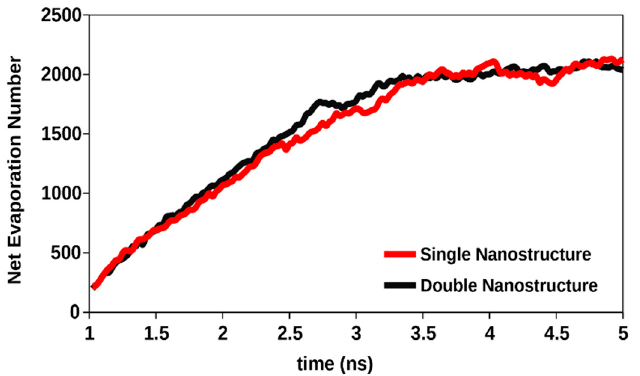
Figure 24. Net evaporation number as a function of time.